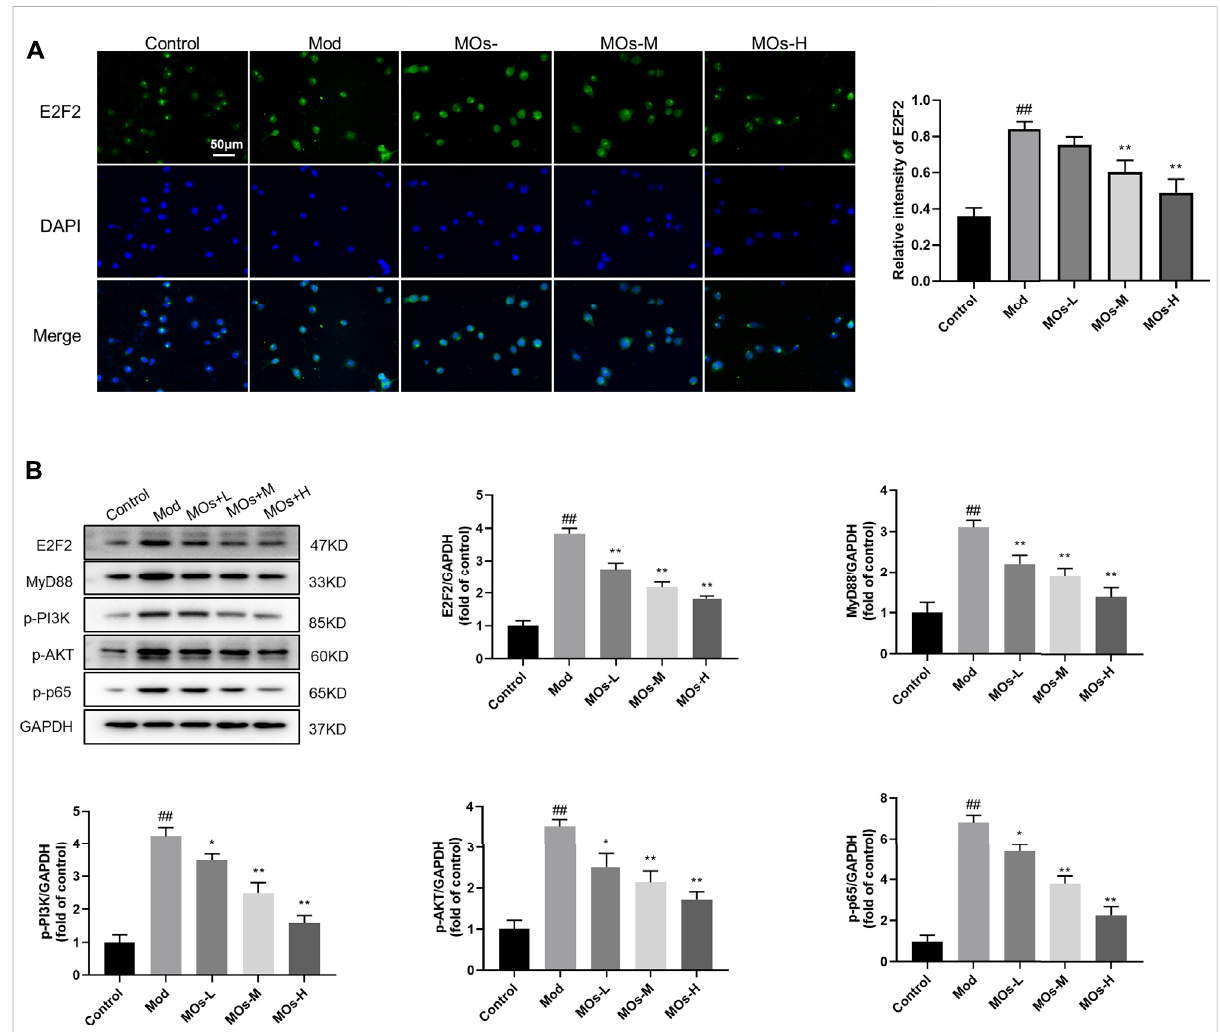
FIGURE 7 Effects of MOs on E2F2-controlled MyD88/PI3K pathway in LPS- and ATP-stimulated BV2 cells. (A) Representative hippocampus immuno fl uorescent staining for E2F2 (green) and nuclei (blue), and quanti fi cation of relative intensity of E2F2. (B) Protein expression levels of E2F2, MyD88,p-PI3K,p-AKTandp-NF- κ Bp65inBV2cells.Dataareexpressedasmeans±SD( n =3).## p < 0.01vs.control; * p < 0.05;** p <